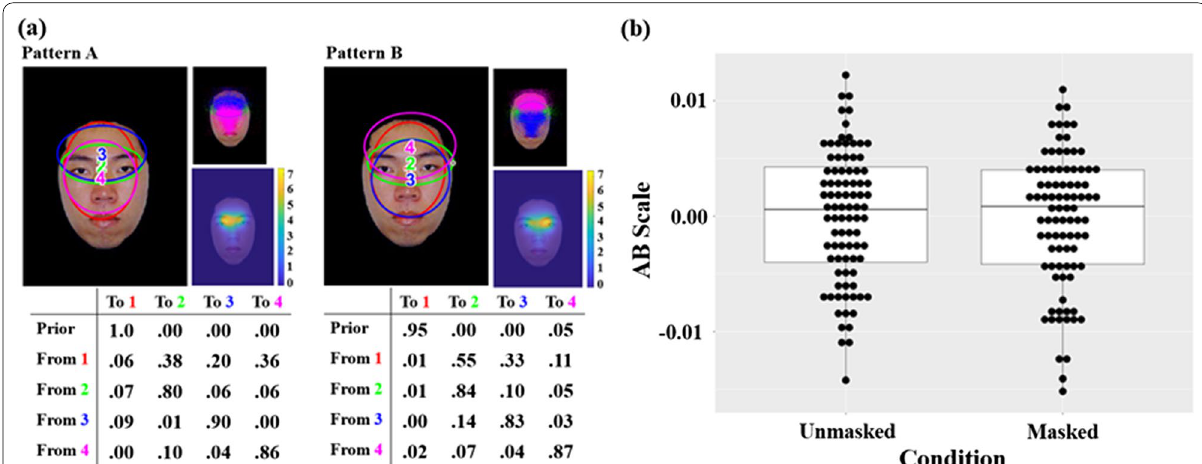
Fig. 2 Eye movement data during face learning. a The two representative eye movement patterns discovered using EMHMM during face learning: In each pattern, ellipses show ROIs as 2‑D Gaussian emissions. Priors in the table show the probabilities that a fixation sequence starts from the ellipse. The table also shows transition probabilities among the ROIs. The smaller image on the top‑right shows the assignment of actual fixations to different ROIs. The assignment of fixations to the ROIs was based on the ROI sequence with the largest posterior probability given the fixation sequence. The smaller image on the bottom‑right shows the corresponding heatmap. b Eye movement pattern measured in A – B scale in the unmasked and masked conditions during face